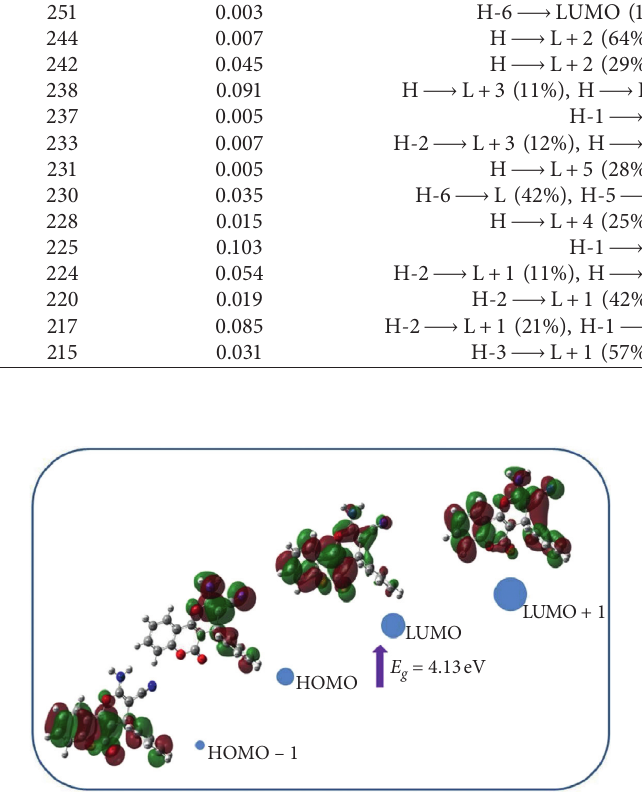
Figure 12: HOMO and LUMO frontier orbitals of the Chrom-D